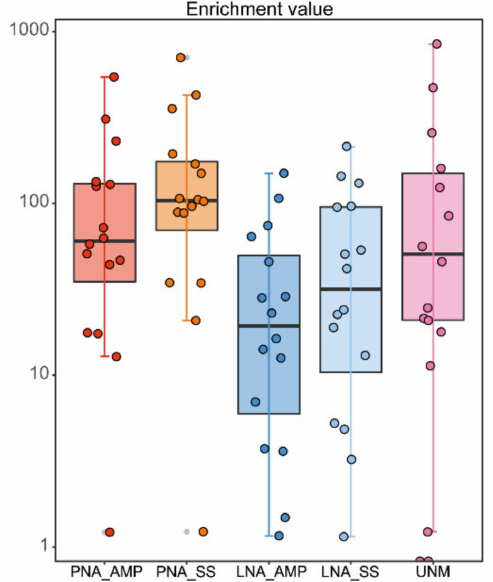
Figure 4. Comparison of non-tick read enrichment values calculated for each method. The non- tick read enrichment value was calculated by dividing the proportion of non-tick reads of each method by that obtained for each individual control. Universal primer sets TAReuk454FWD1 and TAReukREV3 were used for PCRs of the control, TickB_PNA (PNA), and TickB_LNA (LNA). The primer sets EUK581F and EUK1134R were used for the first PCR, and E572F and E1009R were used for the second PCR for UNonMet-PCR (UNM). The purification methods were AMPure (AMP) or SizeSelect (SS). Tick ID 3611 was filtered out because only tick reads were detected in the control method. The non-tick read enrichment value is shown on as a logarithmic scale. Outlier plots are indicated by additional dots in